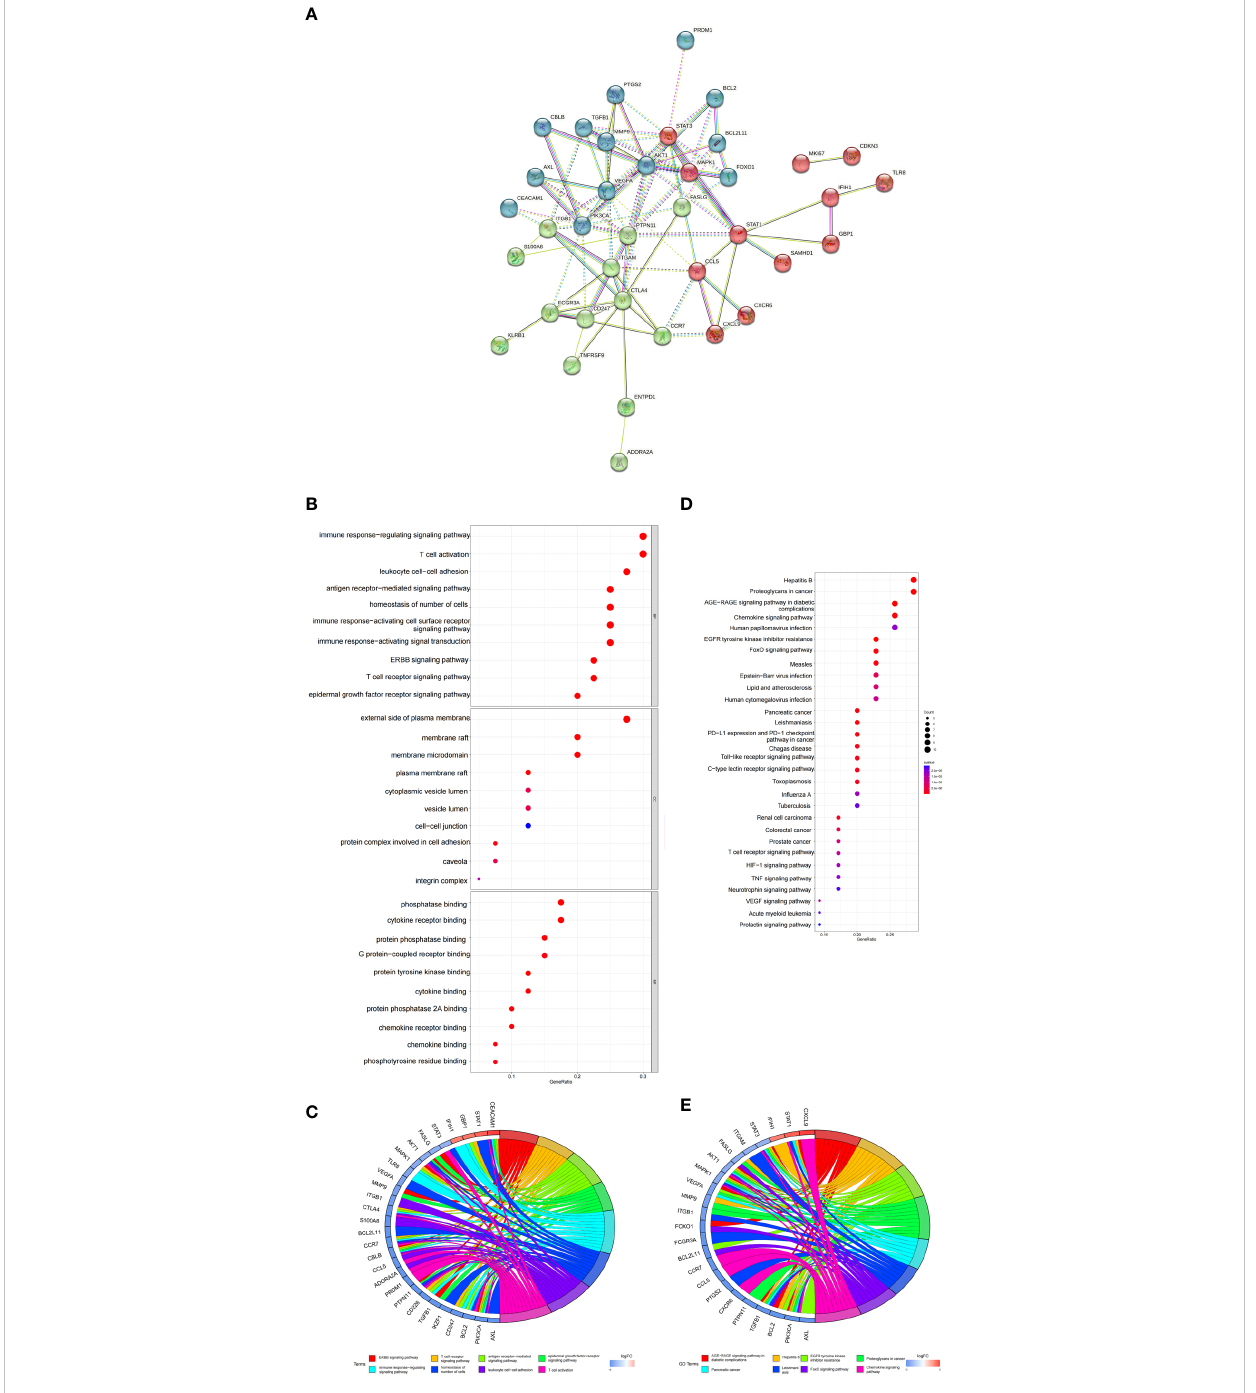
FIGURE 4 PPI networks of IADEGs, and functional analysis. (A) PPI network of IADEGs. Disconnected nodes are hidden. (B, C) The top GO items enriched for IADEGs. (D, E) KEGG pathway enrichment results for